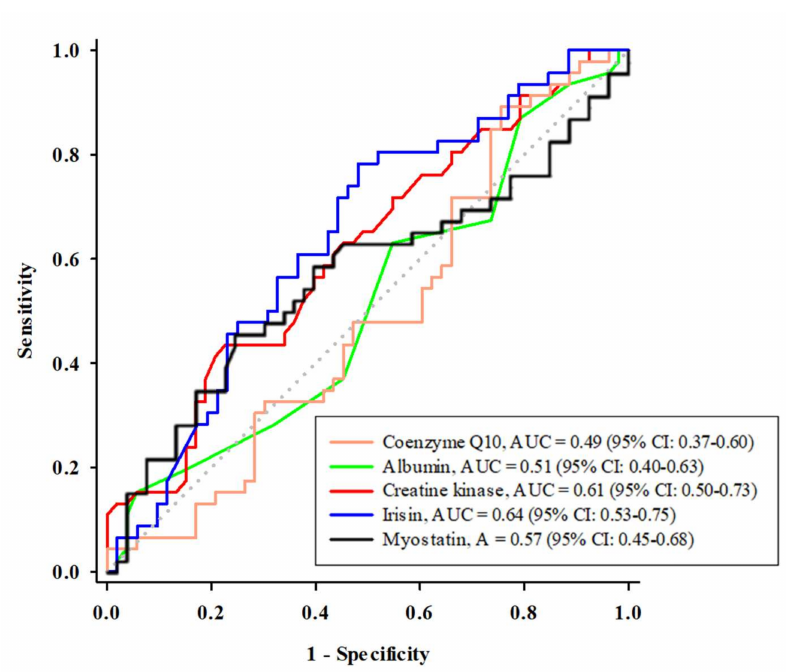
Figure 1. The receiver operating characteristic curve analysis of coenzyme Q10 and the skeletal muscle protein biomarkers in predicting sarcopenia. AUC, area under the curve; CI: confidence interval.